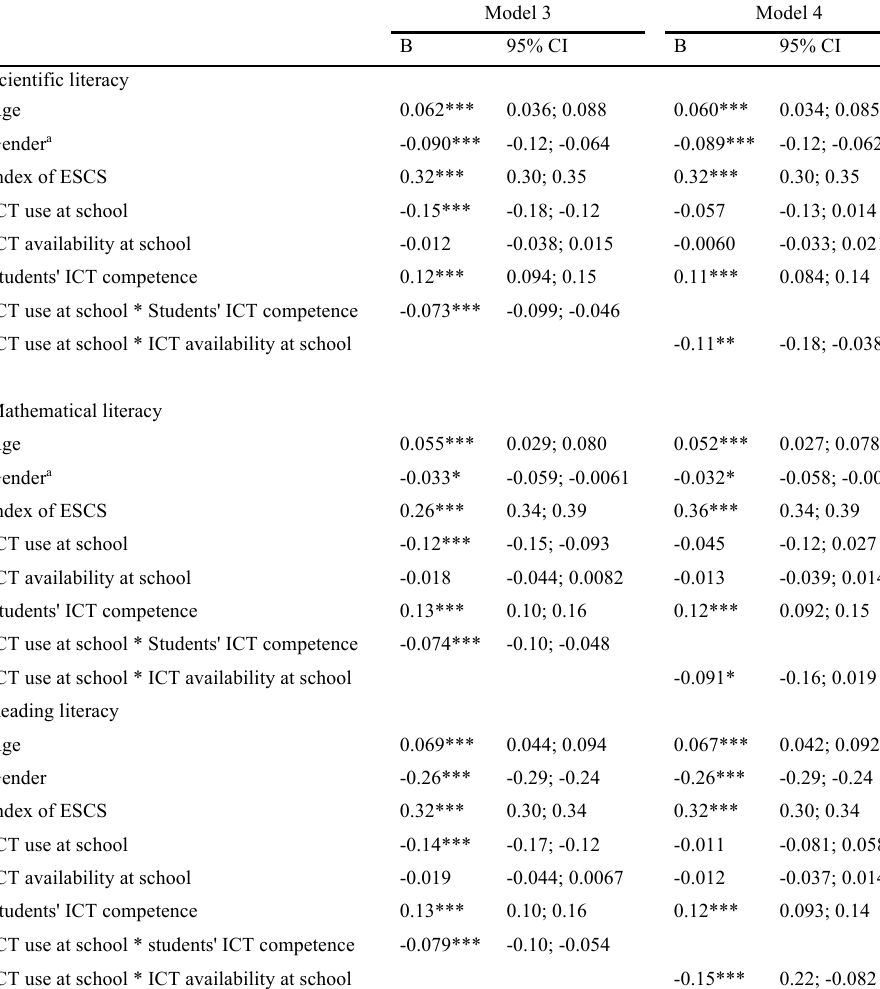
Table 3. The standardized coefficients (B) with 95% confidence intervals of the ICT variables, when predicting students’ learning outcomes with structural equation